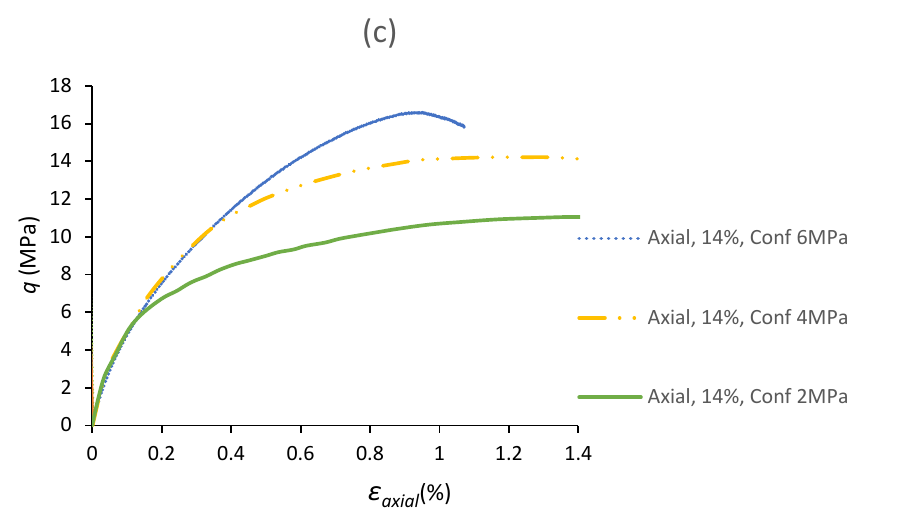
Figure 7. Deviatoric stress versus axial strain for TWHC specimens: ( a ) 10% cement content, ( b ) 12% cement content, ( c ) 14% cement content.